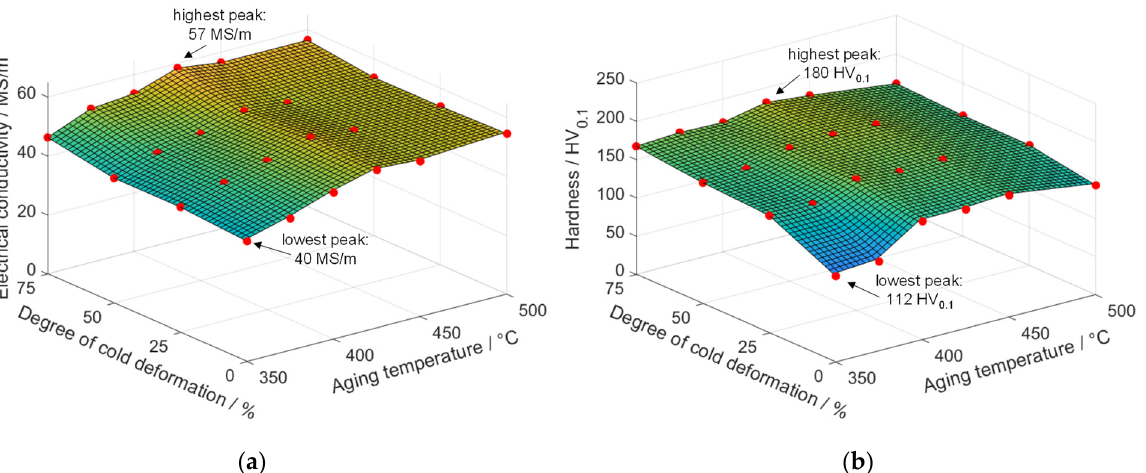
Figure 3. Properties of CuCr0.7 resulting from isothermal aging treatment at 350 °C to 500 °C up to 48 h; ( a ) maximum electrical conductivity; ( b ) maximum hardness.